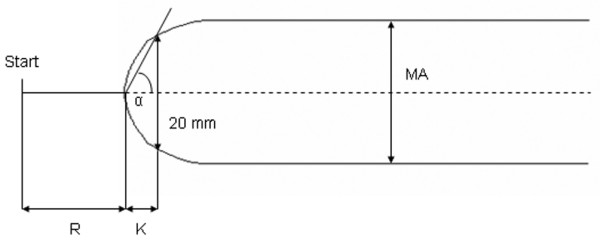
Normal thromboelastograph. α, angle alpha; K, coagulation time; MA, maximal amplitude; R, reaction time.